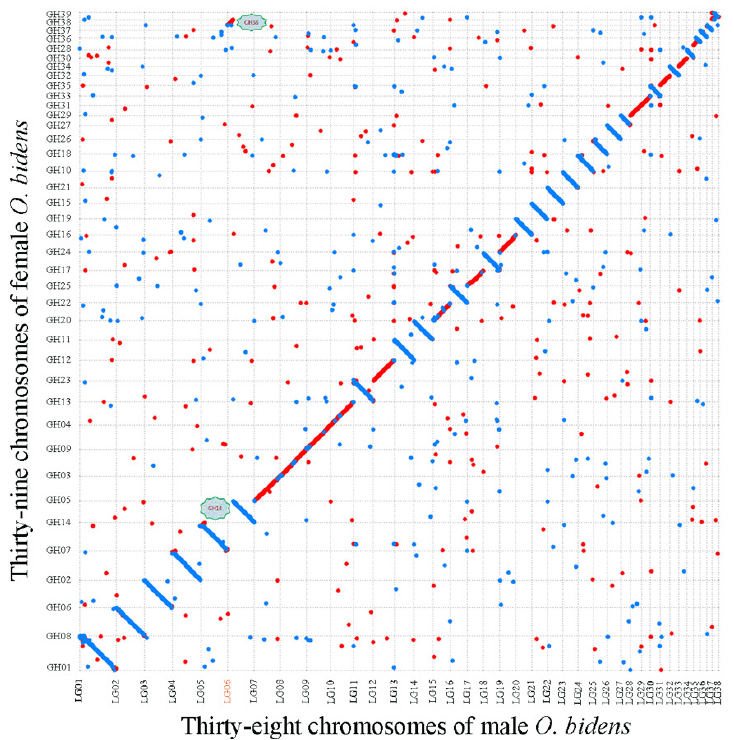
Figure 6. Genomic comparisons between female and male O. bidens . Genomic comparisons of whole genome sequences directly, and the majority of female and male O. bidens chromosomes exhibited 1:1 correspondence except for chromosomes LG06 in male and GH14 and GH38 in